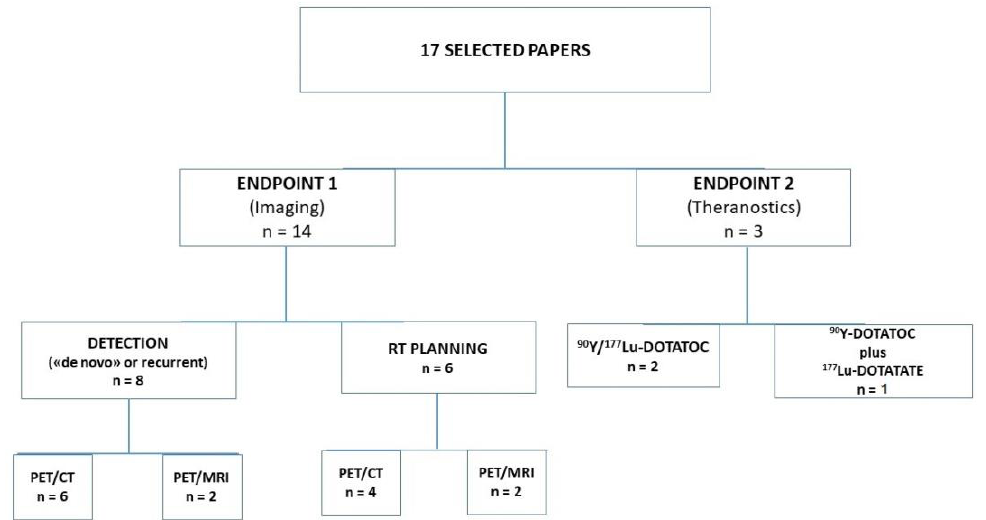
Figure 2. Distribution of the different selected studies for the two endpoints (imaging and theranostics). Imaging studies ( right side ) were further subdivided according to clinical settings (detection or RT planning) and technologies (PET/CT or PET/MRI), while theranostic studies ( left side ) were divided according to the radiopharmaceuticals utilized for therapeutic purposes.